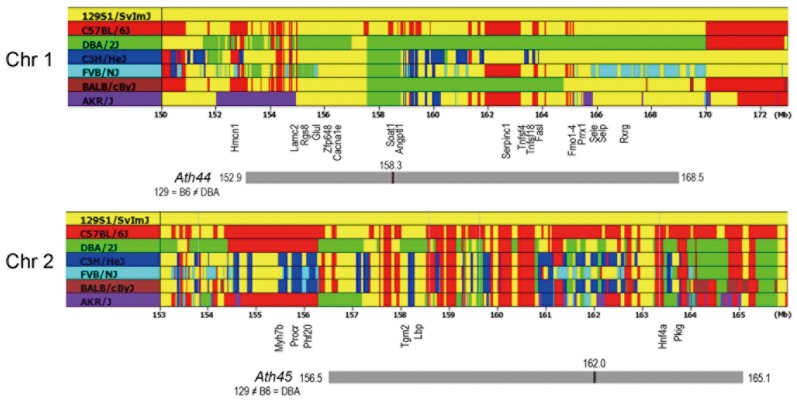
Haplotype analysis.Chromosome maps of Chr 1 and Chr 2 corresponding to Ath44 and Ath45 from the Parlegen Mouse SNP Browser. Sequences of 129 strain are colored by yellow and identical sequences are shown in the same color. Positions of several candidate genes are shown.